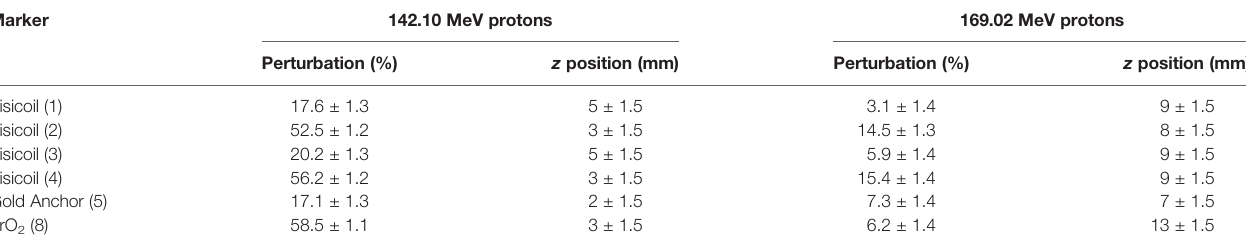
TABLE 5 | Maximum fl uence perturbation values and their position along the beam axis for the different fi ducial markers for 142.10 and 169.02 MeV proton beams.